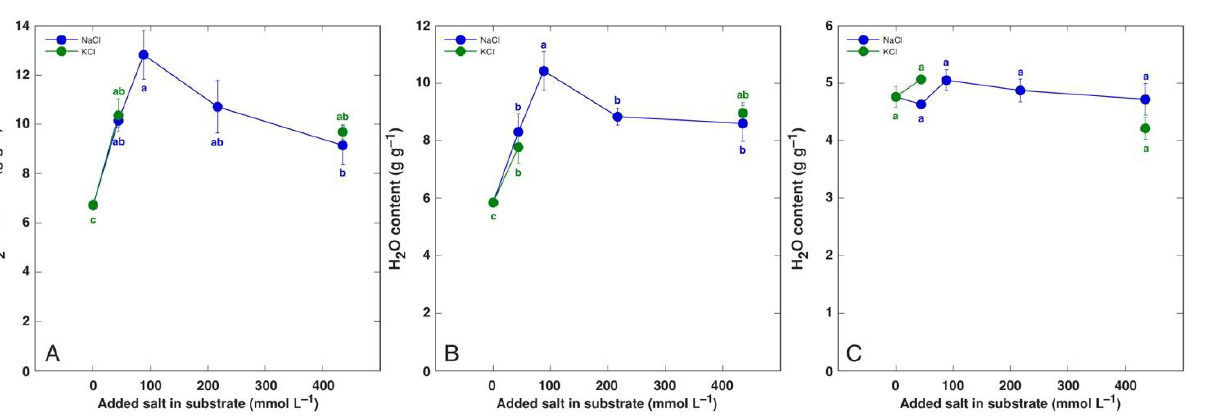
Figure 3. Relationship between shoot water content and Na + accumulation rate ( A ) and transpiration rate ( B ) for salt-secreting ( Glaux maritima, Armeria maritima, Limonium vulgare, Spartina anglica ) and non-salt-secreting ( Juncus maritimus, Juncus articulatus, Atriplex hastata, Atriplex littoralis ) halophyte species grown on 0.2 M NaCl. Data were taken from Rozema et al., 1981 [182] and recalculated.